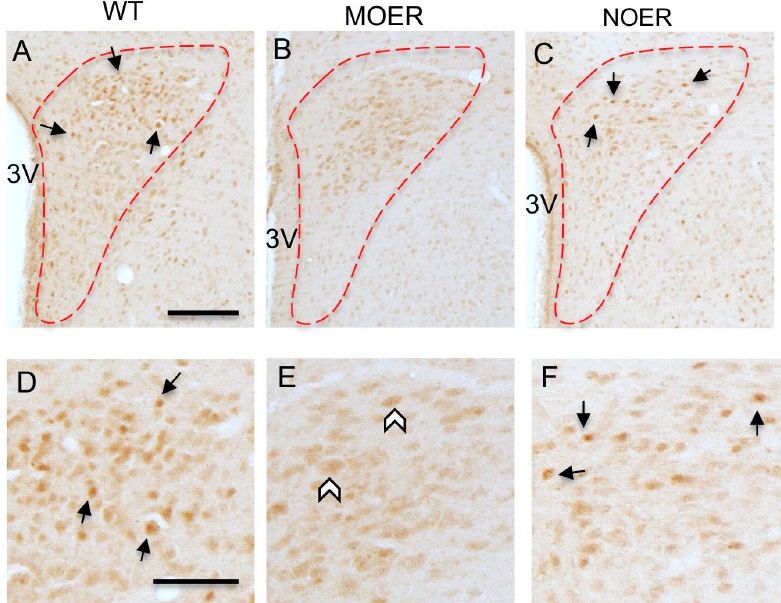
Figure 1. Light microscopic distribution of nuclear ER α in the paraventricular nucleus of the hypothalamus (PVN) from WT, MOER, and NOER female mice. Representative low-magnification micrographs of ER α labeling in the PVN (outline) from WT ( A ), MOER ( B ), and NOER ( C ) mice. Higher magnification of the dorsal parvocellular division showing numerous ER α -labeled nuclei (arrows) in the WT ( D ) and NOER ( F ) mice, but few ER α -labeled nuclei in the MOER mouse ( E ). Examples of extranuclear ER α labeling are also shown (chevrons); 3 V, third ventricle; scale bars (A) = 100 microns, (D) = 50 microns.